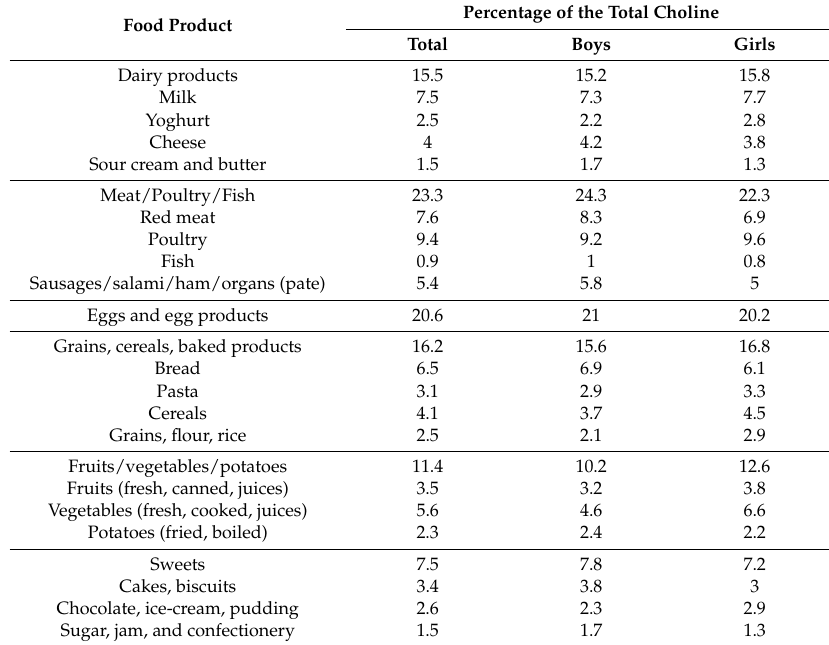
Table 2. Main food sources of total